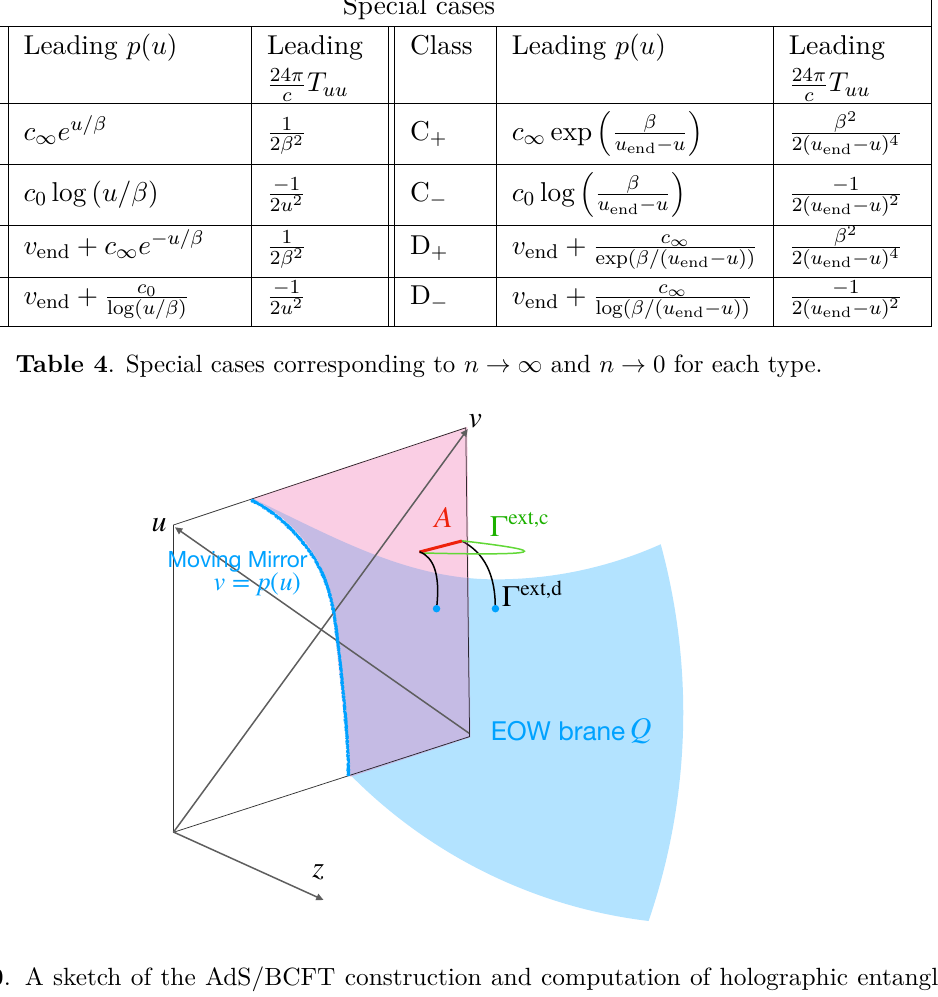
Figure 10 . A sketch of the AdS/BCFT construction and computation of holographic entangle- ment